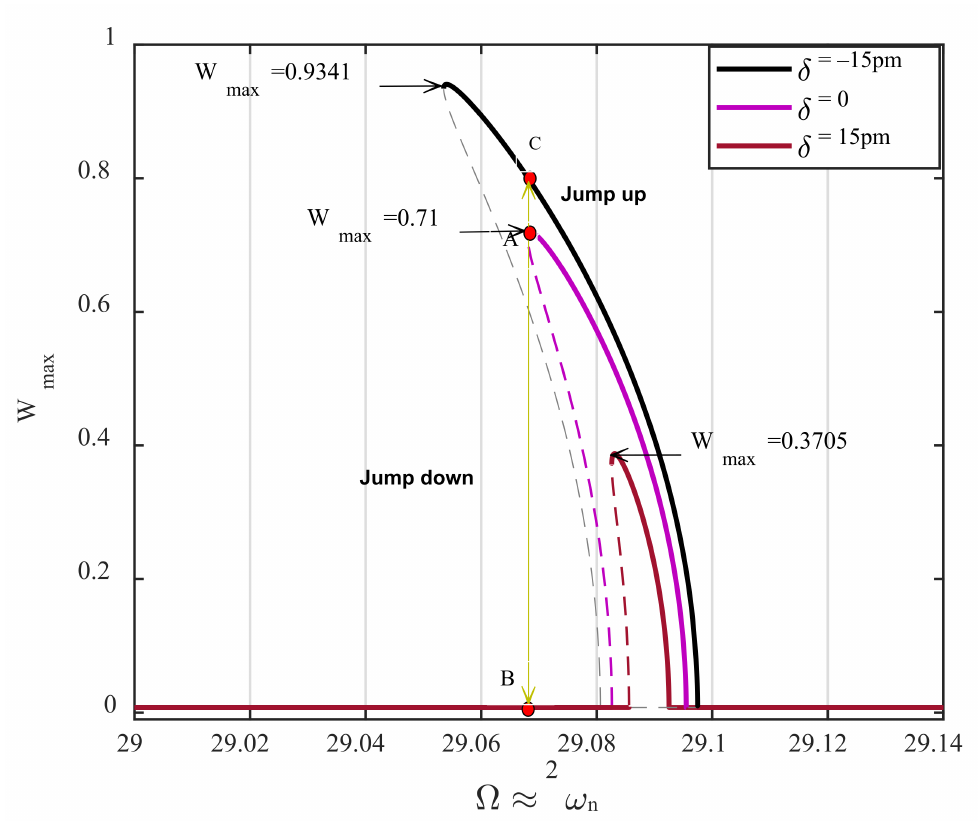
Figure 8. The influence of the surface profile variations on the amplitude of the resonator’s displace- ment at cyclic-fold bifurcation near parametric resonance, for d 0 are unstable and stable branches,